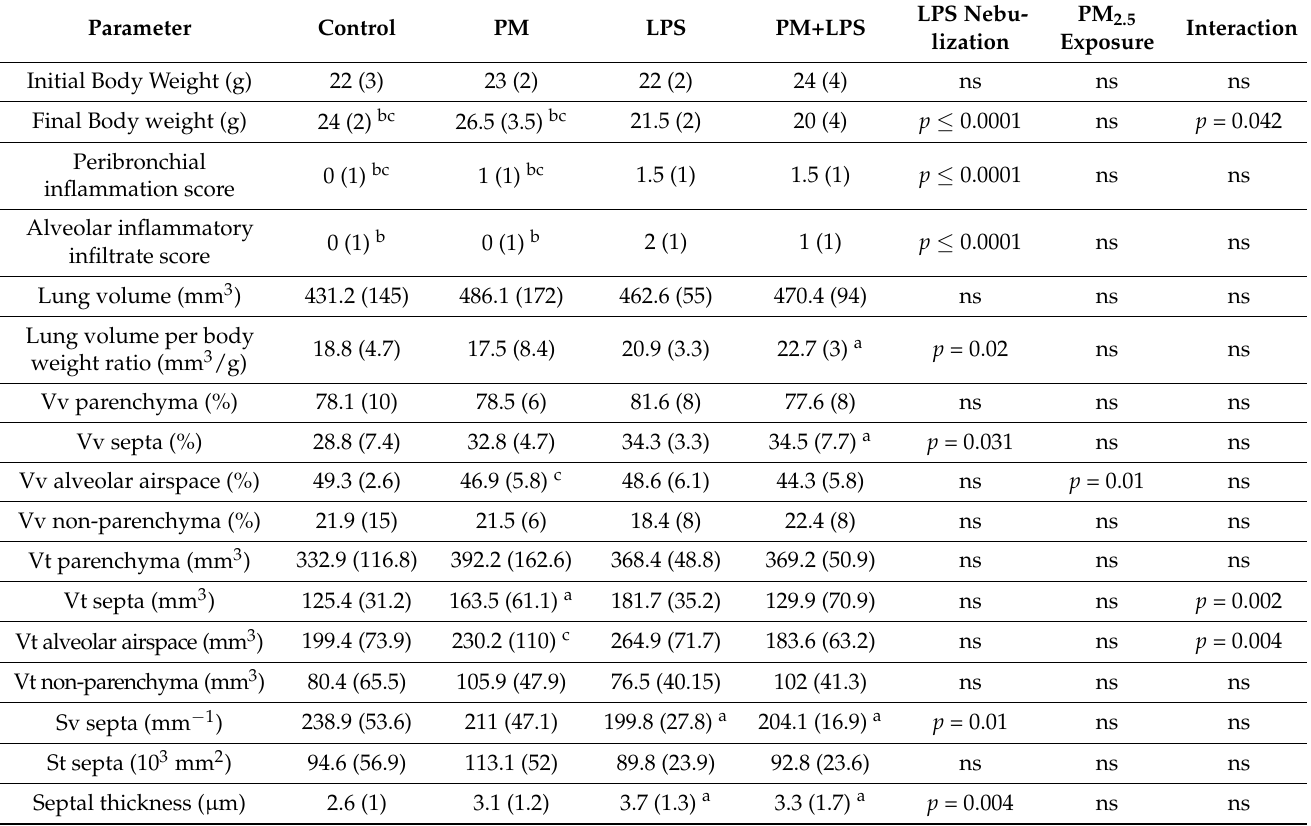
Table 1. Semi-quantitative analysis of the inflammation and stereological assessment of the lung